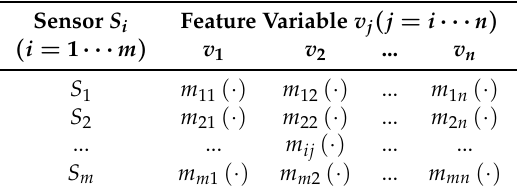
Table 5. The obtained m × n groups of